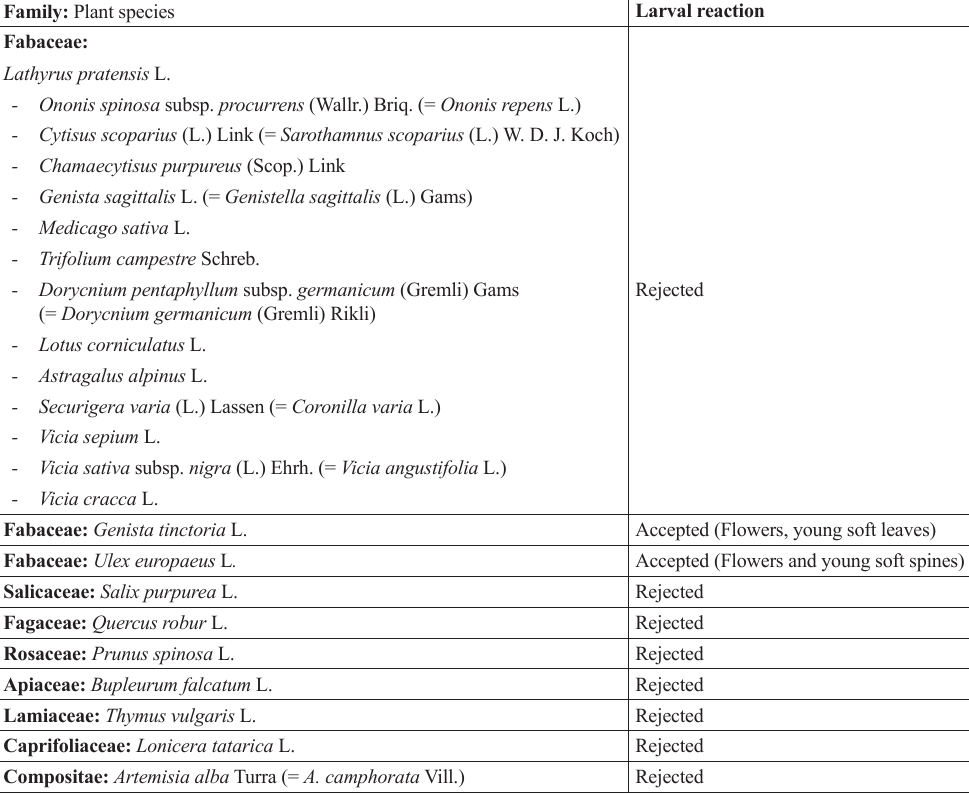
Table 1. Isturgia sparsaria (Hübner, 1809): larval reactions to plants (listed by family) offered under cap - tive conditions (botanic nomenclature according to The Euro+Med Plant Base: http://www.emplantbase.org/